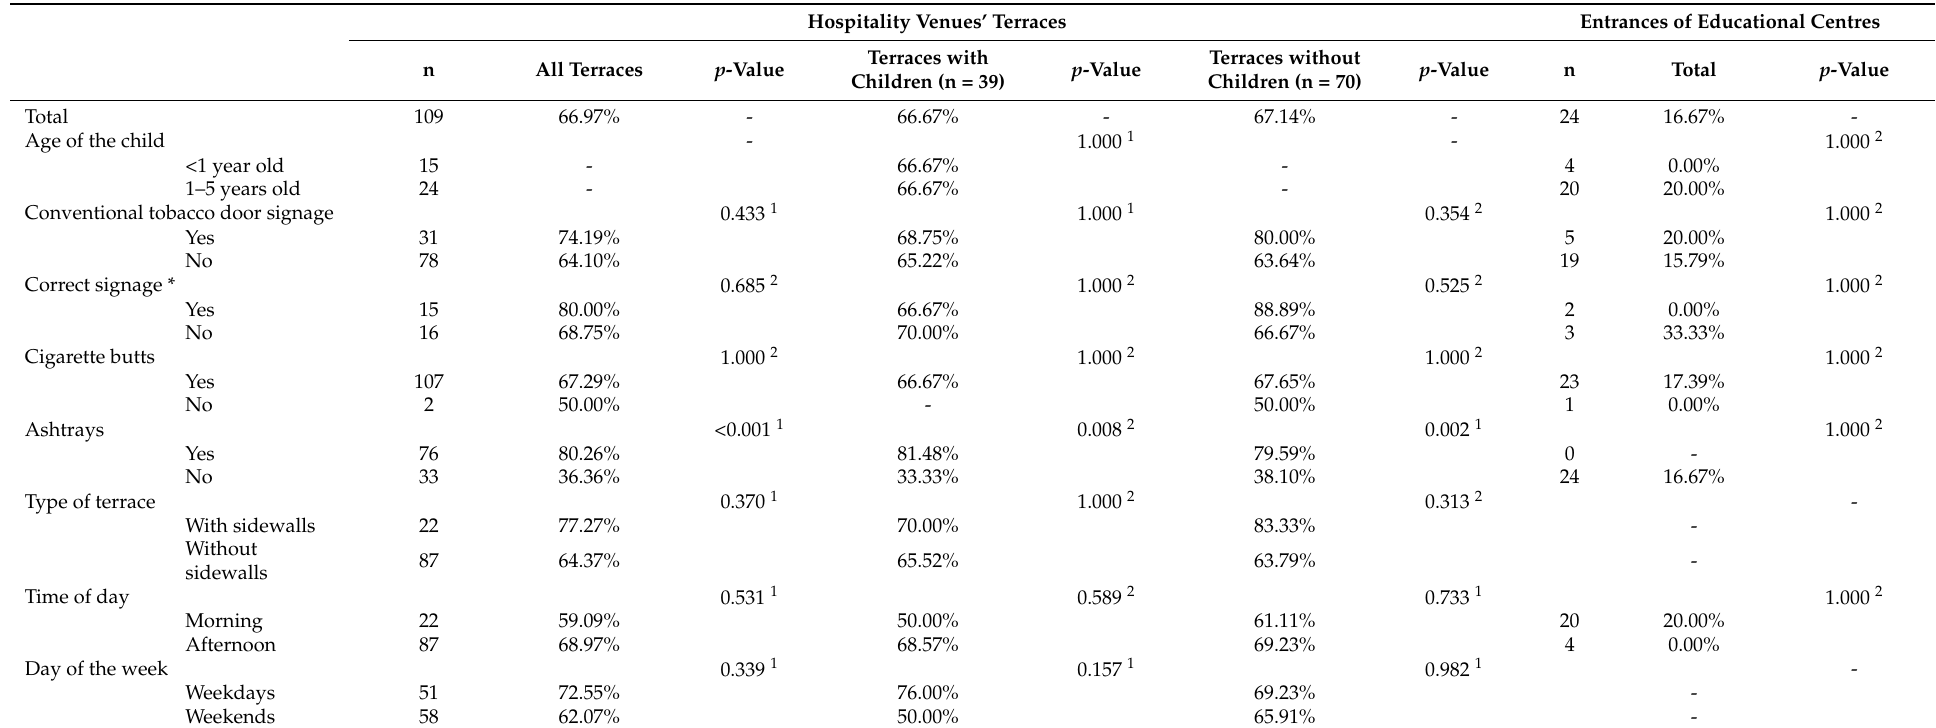
Table 2. Percentage of tobacco consumption in hospitality venues’ terraces and at the entrances of educational centres according to the presence of children (up to 5 years old) by